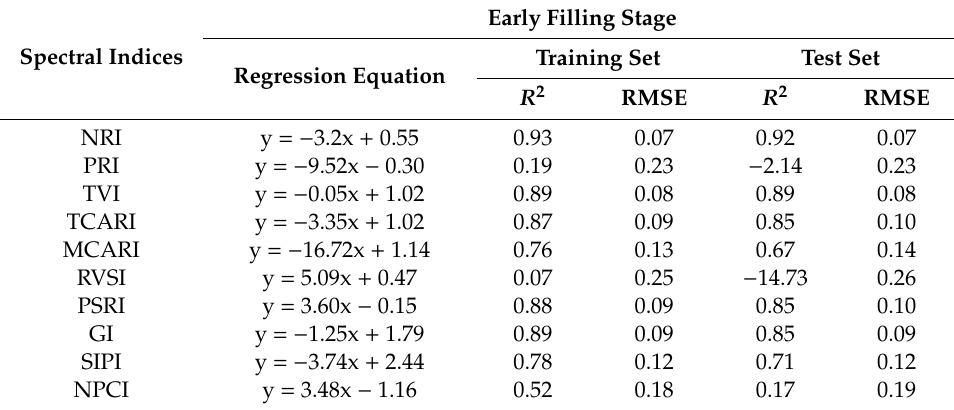
Table 3. Comparison of proposed FDI and traditional spectral indices at the early filling stage.